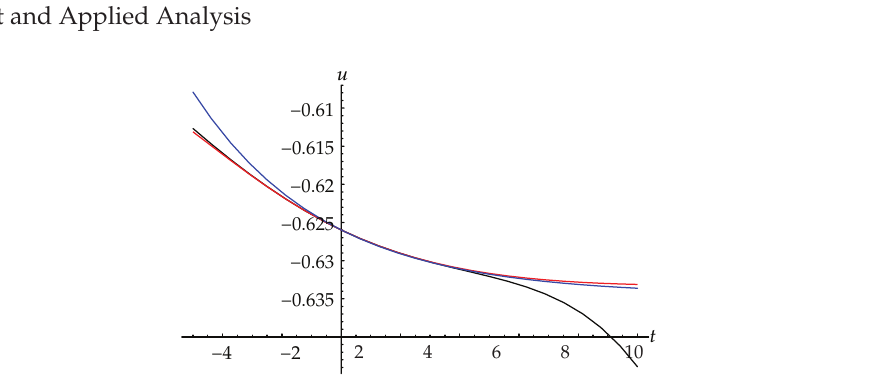
Figure 1: The compared results for the GDTM solutions (cid:4) black (cid:5) , the GDTM-Pad´e solutions (cid:4) red (cid:5) , and the exact solutions (cid:4) blue (cid:5) of (cid:4) 1.1 (cid:5) .